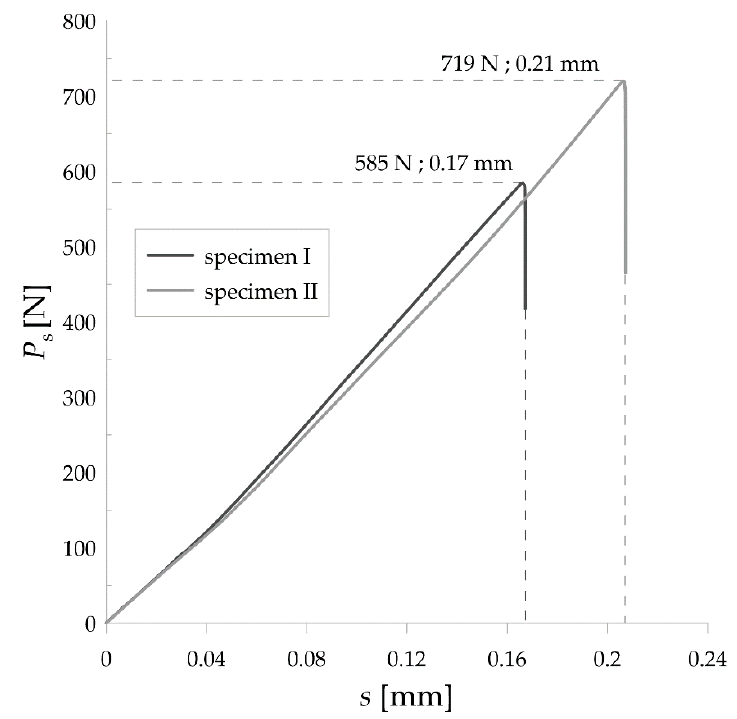
Materials 2021 , 14 , x FOR PEER REVIEW Figure 3. Static force versus displacement for the two tested SM25T specimens. Figure 3. Static force versus displacement for the two tested SM25T specimens.